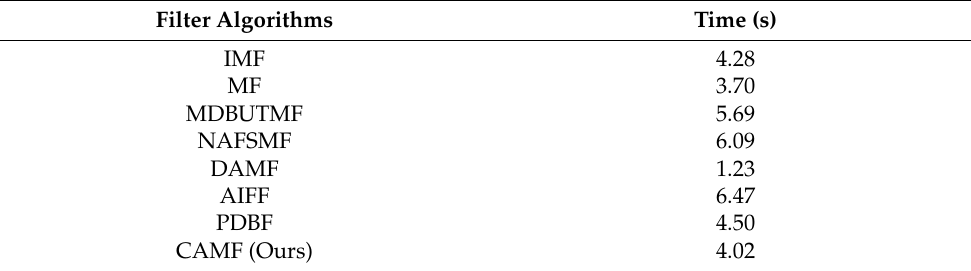
Table 2. Comparison of execution time between CAMF and the above filtering algorithms. Filter